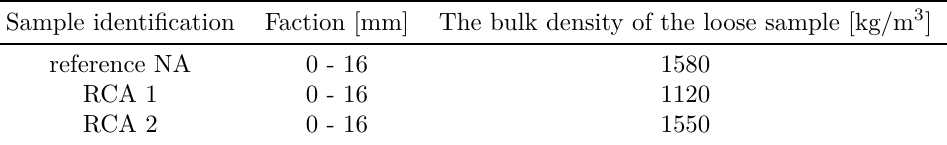
Table 6. Determination of bulk density of loose